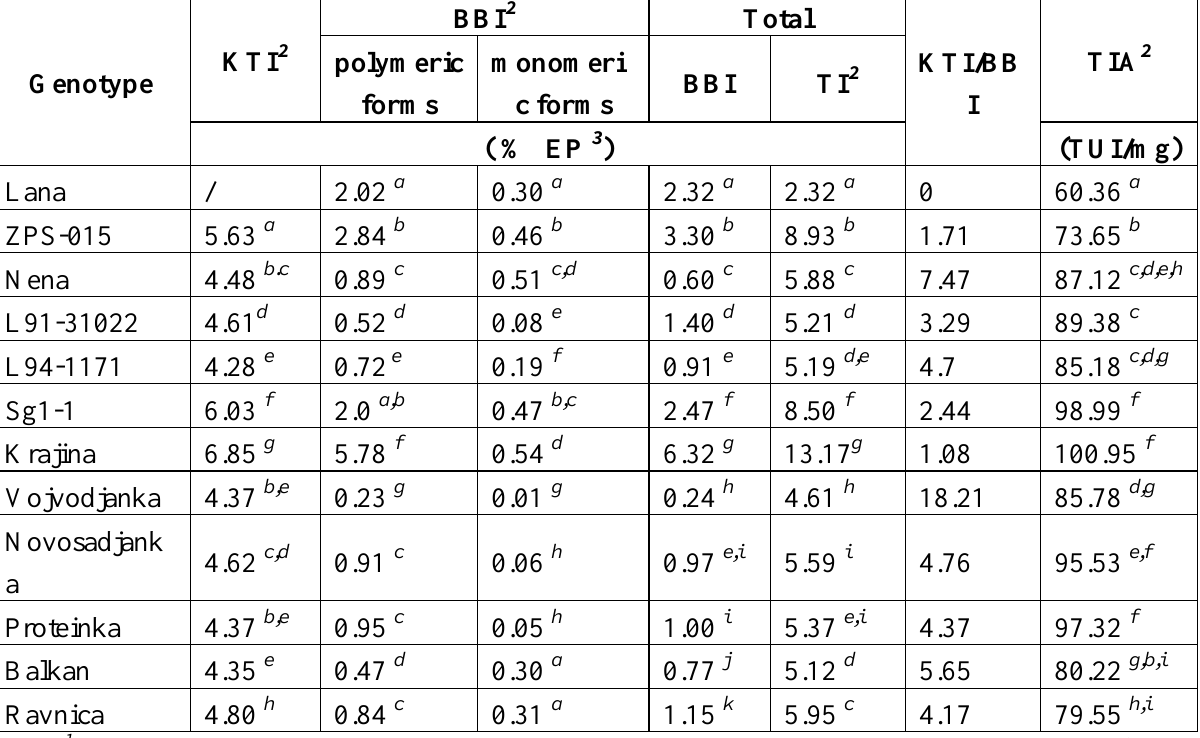
Table 1. Trypsin Inhibitors Composition of the Investigated Soybean Genotypes 1